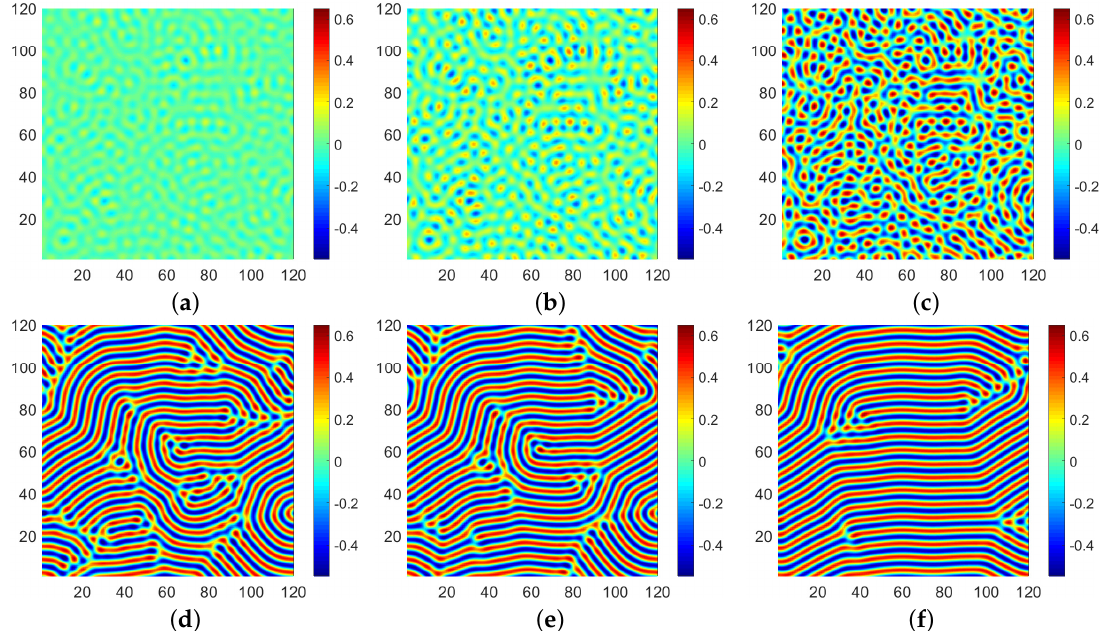
Figure 15. ( a – f ) are the snapshots of numerical solutions of the SH equation with the initial condition (47) at t = 1200 ∆ t , 1800 ∆ t , 3000 ∆ t , 30,000 ∆ t , 60,000 ∆ t , and 150,000 ∆ t , respectively. For colored figures, see the manuscript of web version.